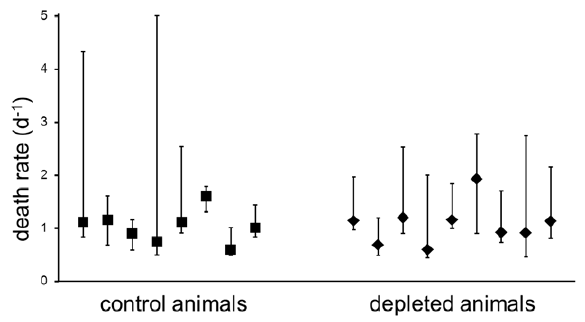
Figure 2. Estimated death rate of short-lived productively infected cells. Error bars represent the 95% confidence interval calculated using the optimal method (bootstrapping the cases and trimming the extremes).